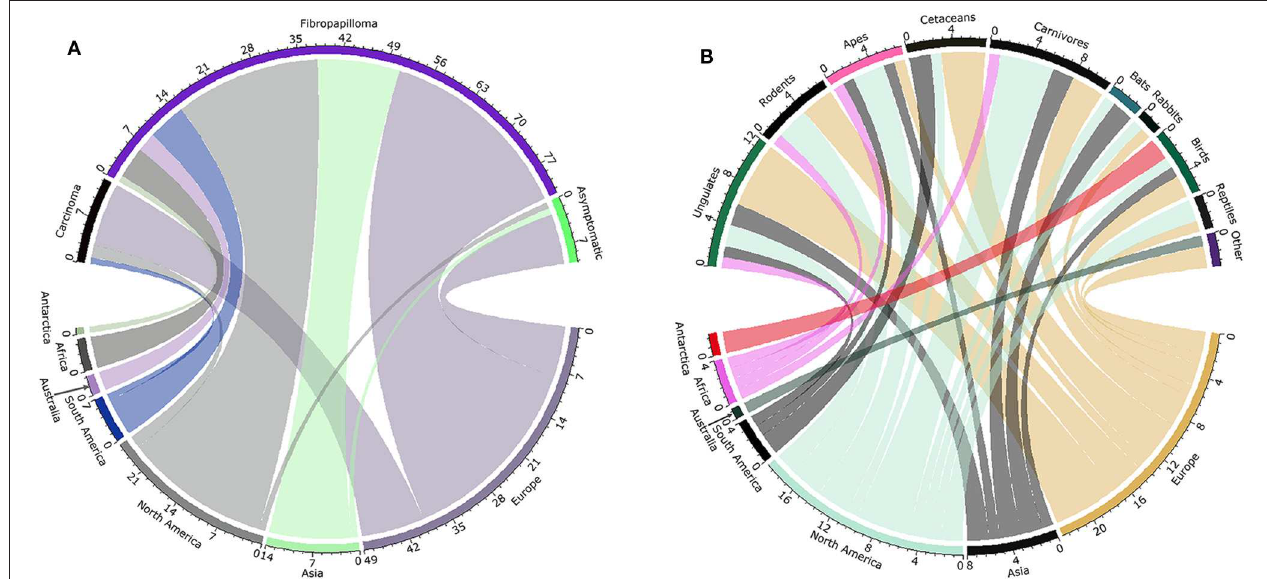
FIGURE 1 | Wildlife papillomavirus (WPV) reports by continent, symptomatology, and host. (A) Frequency of WPV symptoms (black: carcinoma, purple: fibropapilloma, green: asymptomatic) by region (olive: Antarctic, dark gray: Africa, blue: South America, light gray: North America: light green: Asia, gray: Europe). (B) Frequency of reports by continent (red: Antarctica; pink: Africa; olive: Australia; black: South America; light green: North America; black: Asia; yellow: Europe) and host group (green: ungulates; black: rodents; pink: apes; black: cetaceans; black: carnivores; blue: bats; black: rabbits; dark green: birds; black: reptiles; purple: Other species, i.e., marsupials, manatees). Both chord diagrams show the high frequency of reports from the northern Hemisphere (North America and